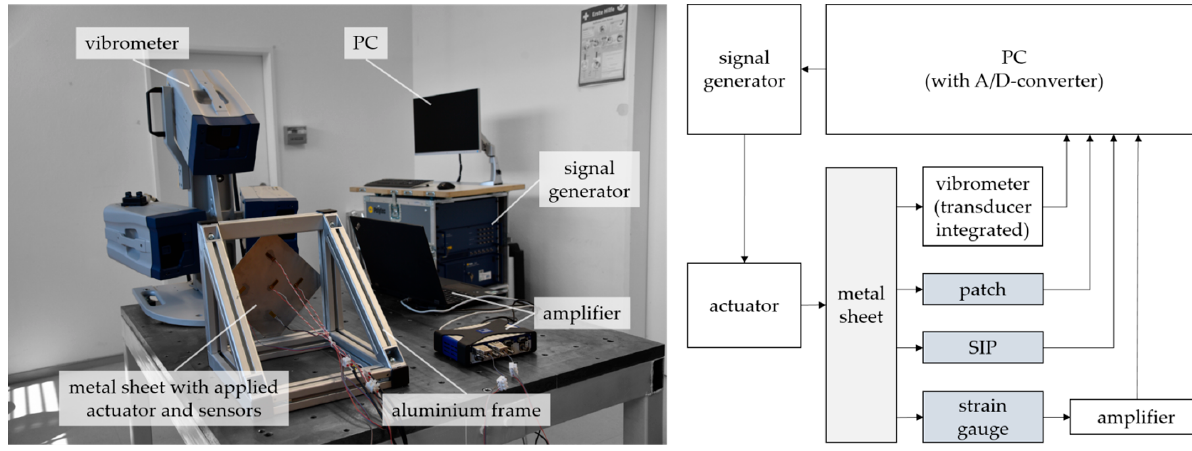
Figure 5. Experimental